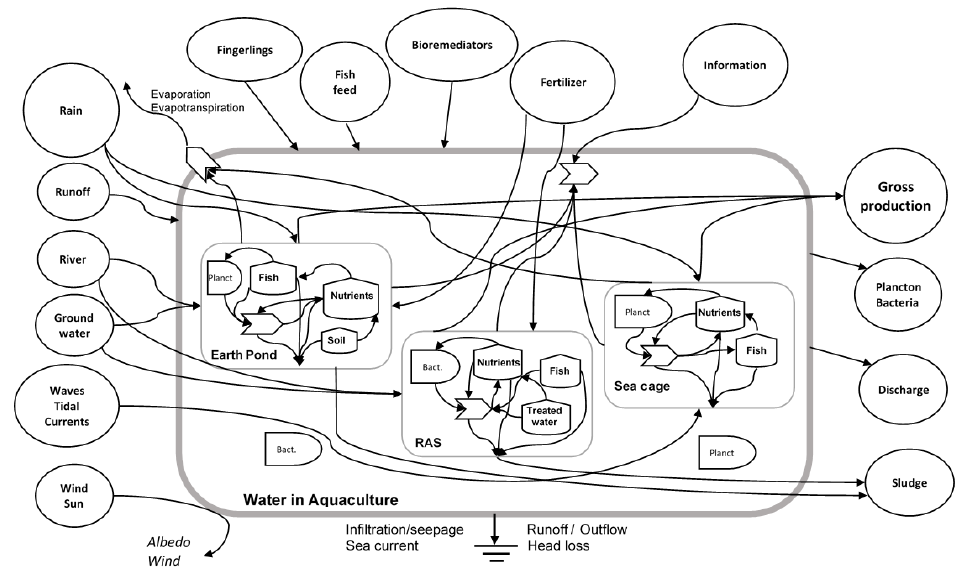
Figure 8. Diagram of water energy systems in aquaculture of three systems identified in this study land pond, RAS, and cage culture.